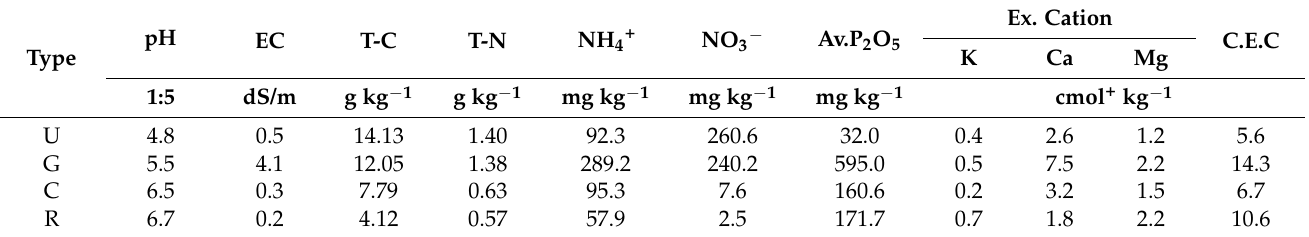
Table 1. Chemical properties by soil characteristics in agricultural land.